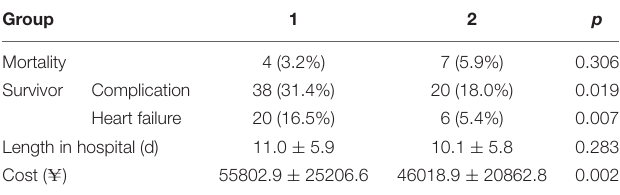
TABLE 4 | Comparison of outcome between two groups.